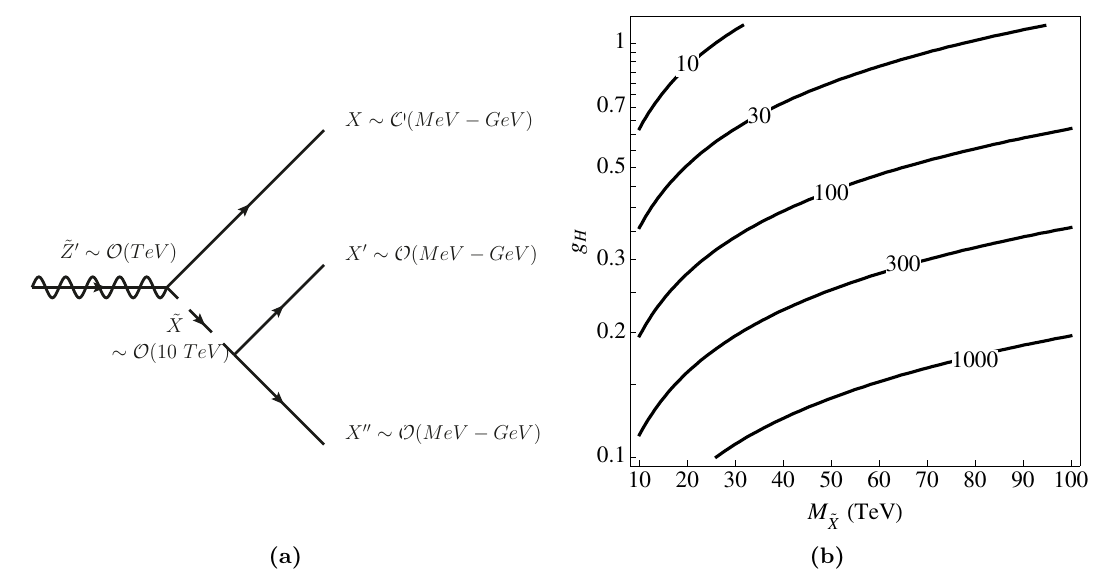
Figure 7. (a) A diagram showing the potential decay of a hidden sector gaugino to hidden sector chiral fermions, including the dark matter candidate X . (b) Contours showing the decay time (in seconds) of the hidden sector gaugino ~ Z 0 to three light hidden sector chiral fermions f through a scalar mediator ~ X , shown as a function of both the hidden sector gauge coupling g H , and the mass of ~ X . The mediator mass is expected to be of order m 3 of 10-100 TeV. The gauge coupling range we have chosen so that it includes the couplings we found for the SU(5) example in the appendix. We have set the Yukawa coupling of the chiral fermions such that M f = 1 MeV. We have taken the mass of the hidden gaugino to be M ~ as could be expected for example, from anomaly mediation [38{40,